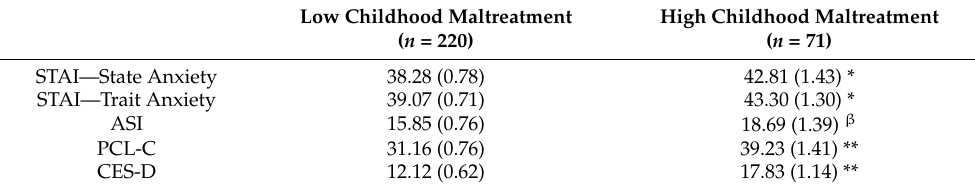
Table 1. Self-report scores (means ± SEM) for low and high childhood maltreatment